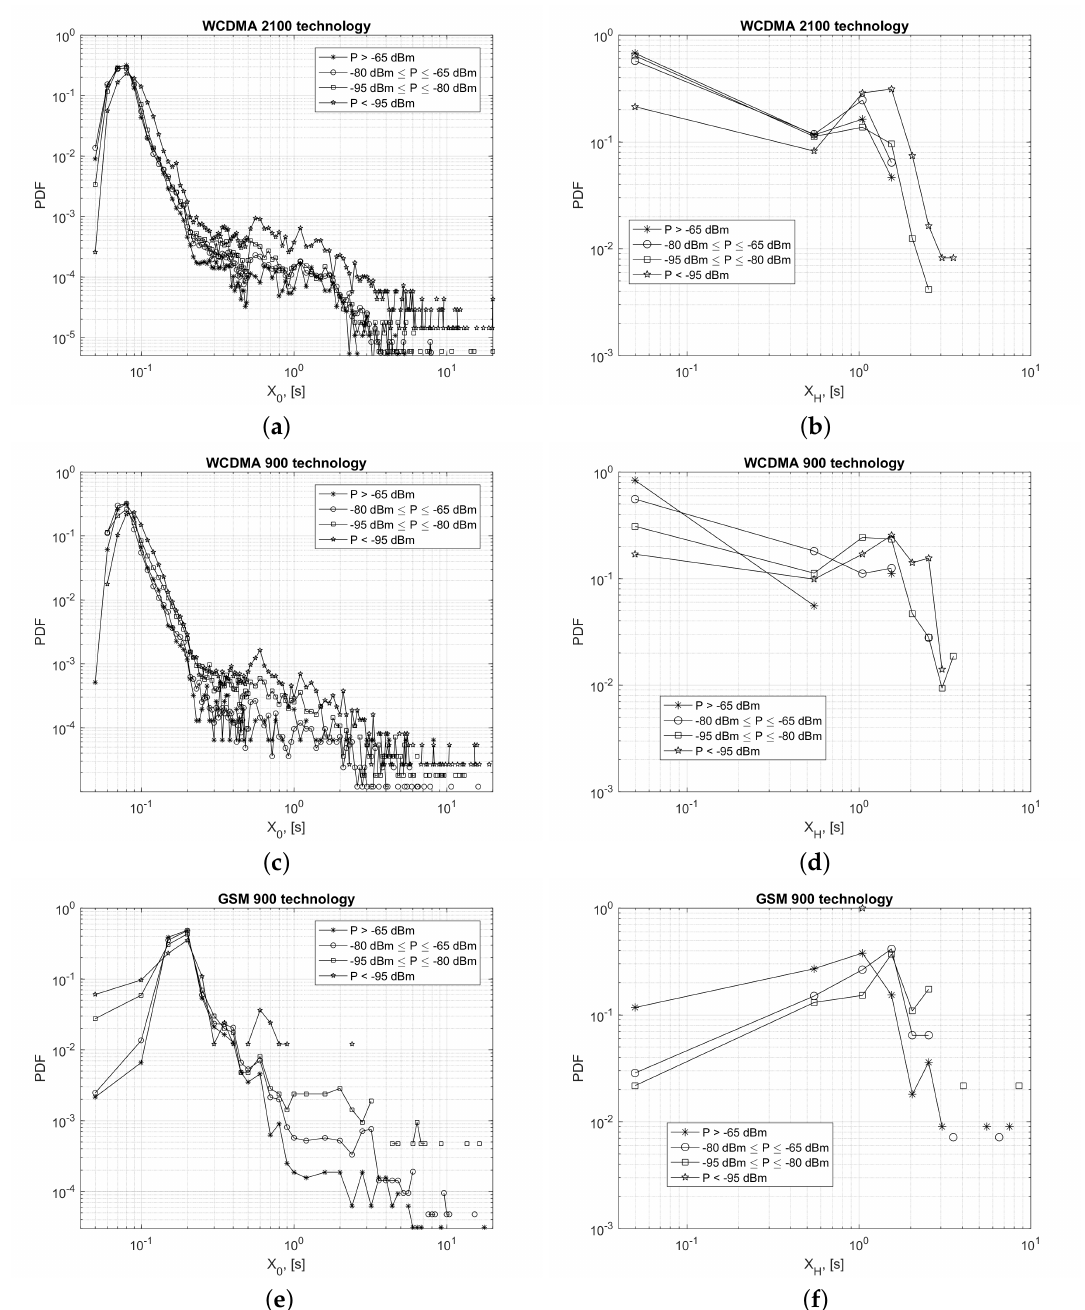
Figure 9. Probability Density Functions of the random variables X 0 and X H obtained from experimental data ranked by technology and the received power interval: X 0 and X H for WCDMA 2100 ( a , b ); X 0 and X H for WCDMA 900 ( c , d ); X 0 and X H for GSM 900 ( e , f